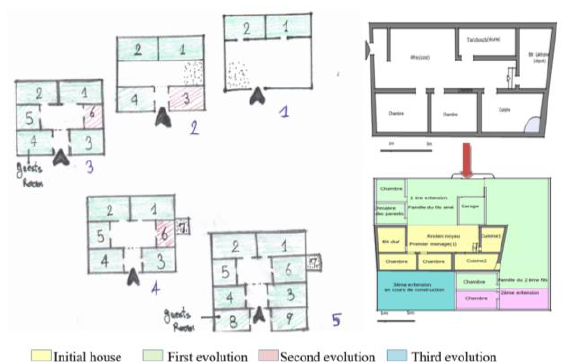
Figure 13 . Two Transformation strategies and evolution of domestic spaces in Aoughanim village. Authors, 2016 (Left); 2017(Right).